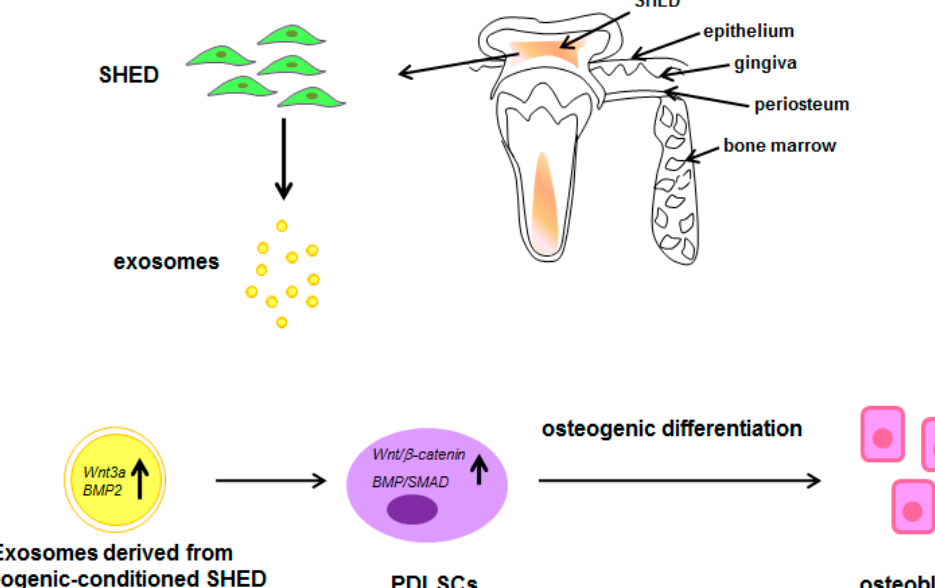
Figure 1. Schematic representation of ZOL-macrophage cross-talk mechanisms. ZOL-mediated Figure 5. Schematic representation of the paracrine e ff ects of exosomes derived from SHED. Figure 5. Schematic representation of the paracrine effects of exosomes derived from SHED. activation of TLR4 in macrophages accounted for the overexpression of mature form of IL-1 β leading Exosomes derived from osteogenic-conditioned SHED induce PDLSCs osteogenic di ff erentiation via to M1- polarization. Red arrows indicate the action of ZOL on TLR4 activation and Kdm6 proteins Exosomes derived from osteogenic-conditioned SHED induce PDLSCs osteogenic differentiation via the activation of Wnt / β -catenin and BMP / Smad signaling pathways. overexpression. the activation of Wnt/ β -catenin and BMP/Smad signaling pathways. arrows indicate the direction of the flow; BMP2: Bone morphogenetic protein 2; PDLSCs: periodontal ligament stem cells; SHED: stem cells from exfoliated deciduous teeth; SMAD: small mother against decapentaplegic; Wnt3a: Wingless-related integration site family member 3A. See text for explanation [132].